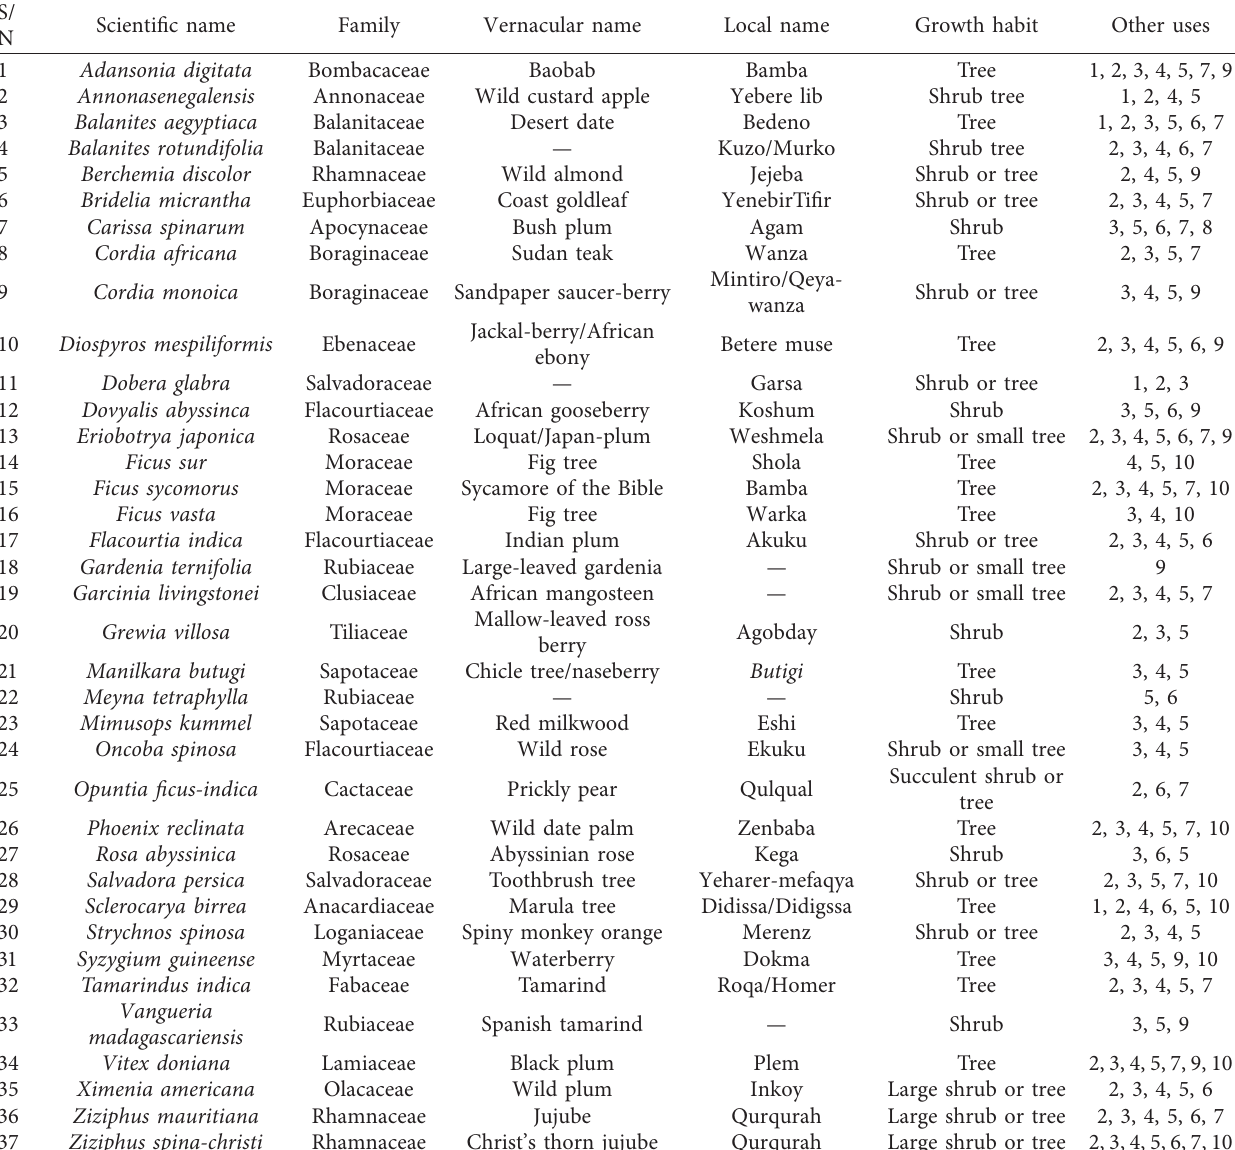
Table 3: Common wild edible fruit tree and shrub